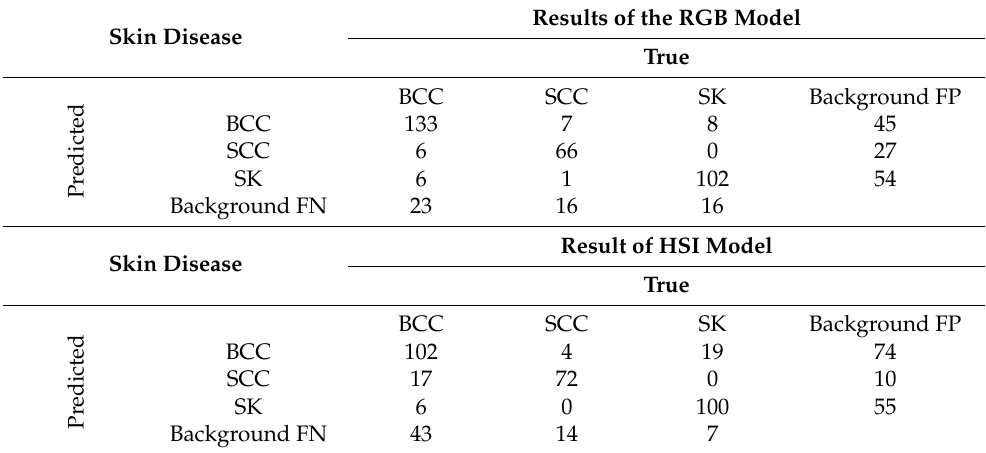
Table 1. Confusion matrix for the YOLOv5 detection model.